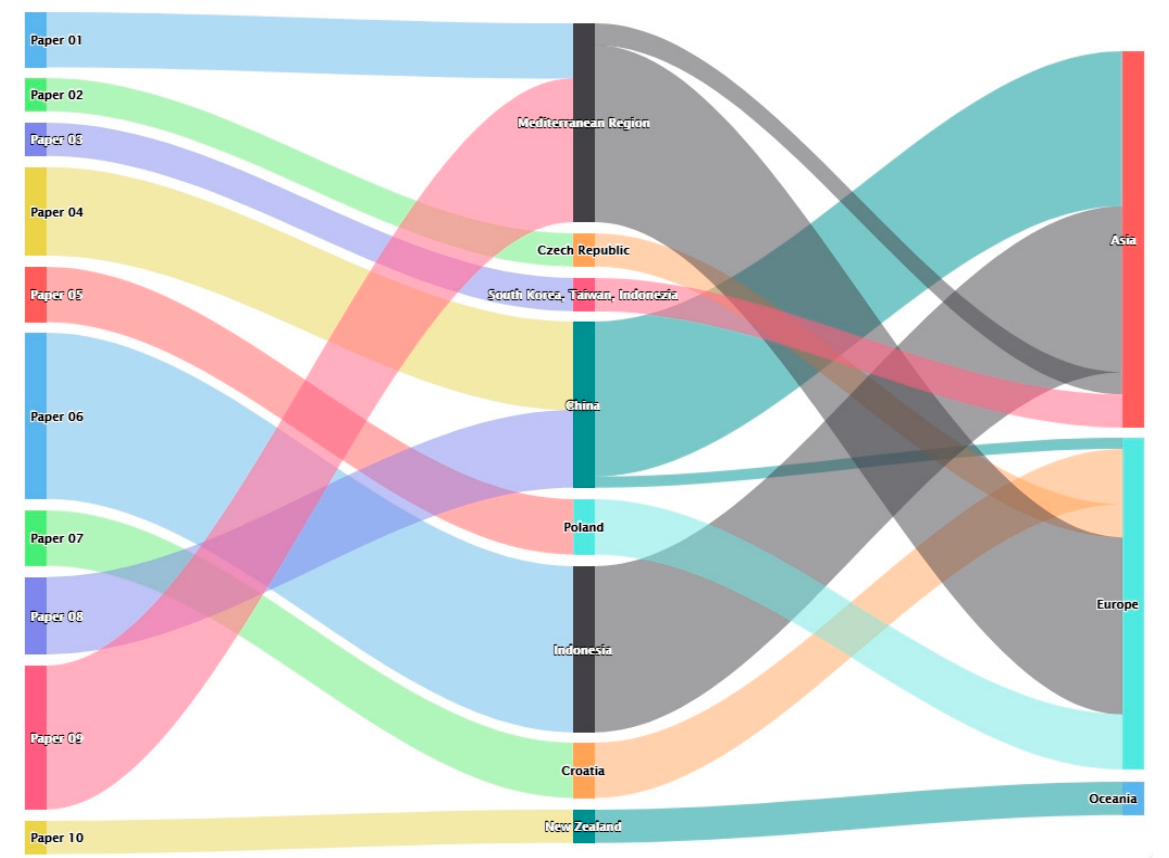
Figure 1. Study areas of the papers in this Special Issue (left: paper number, according to the references; middle: study area; and right: continents). Data source: [1–10].